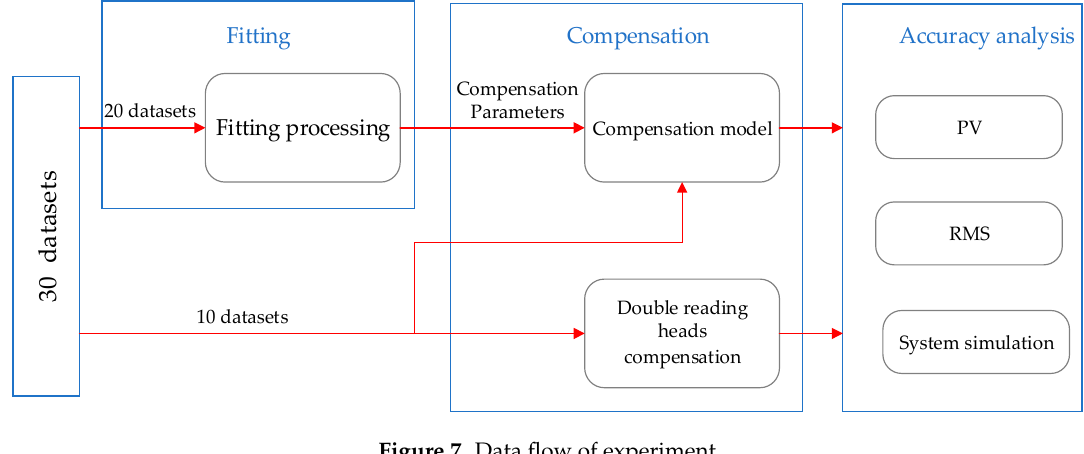
Figure 7. Data flow of experiment. Table 2. Fitting results.